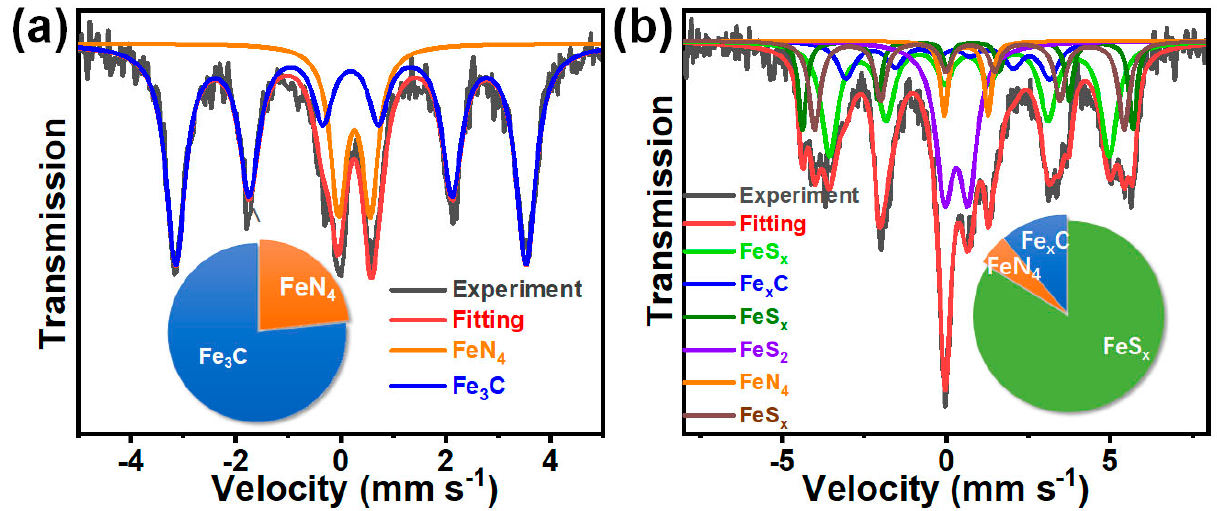
Figure 4. Mössbauer spectra of ( a ) MIL-88-850 and ( b ) FeNSC-850, with the assignment of Mössbauer sites to iron species in the relative absorption area. Table 1. The Mössbauer spectra parameters of MIL ‐ 88 ‐ 850 and FeNSC ‐ 850.